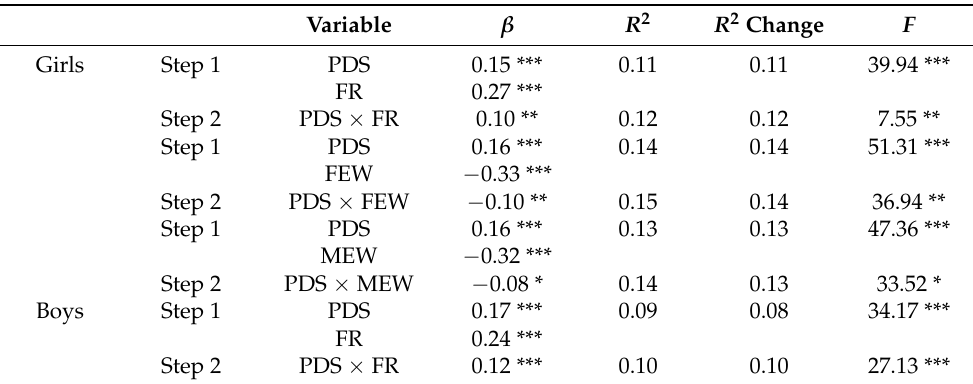
Table 4. Regression analyses testing parenting style as moderators of the relation between pubertal timing and smoking